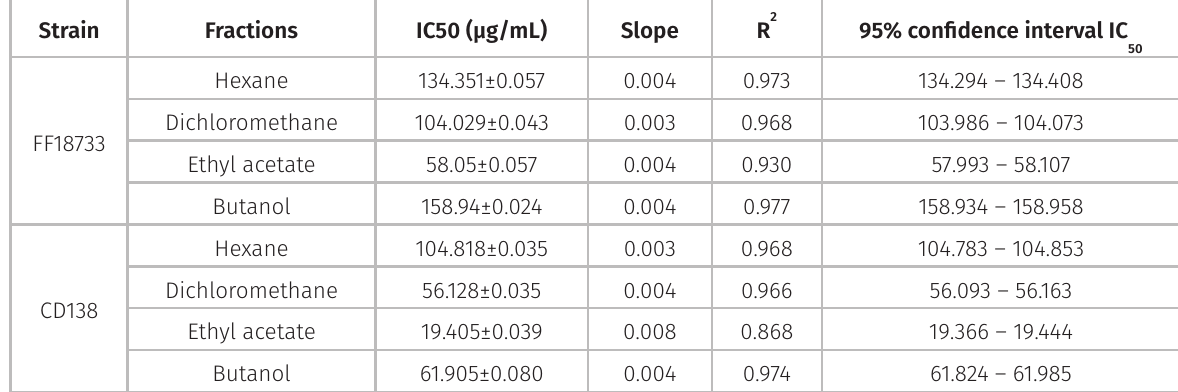
Table I. Cytotoxicity of Hovenia dulcis ethanolic extract fractions on strains of S. cerevisiae .